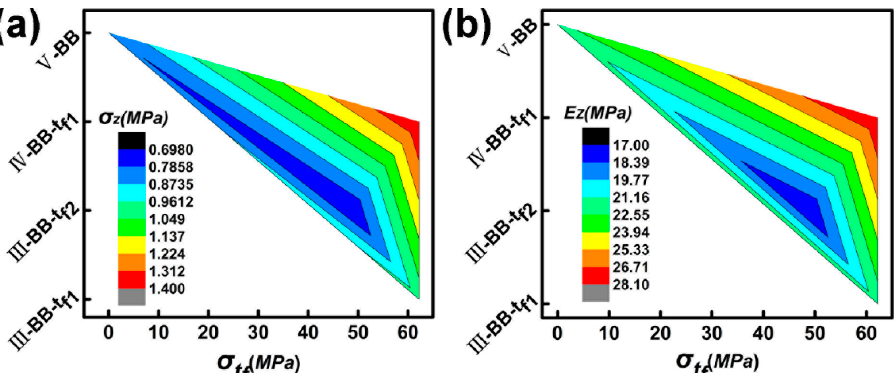
Figure 15. ( a ) Strength–strength of intermediate support plate–configuration comparison diagram. ( b ) Young’s modulus–the strength of intermediate support plate–configuration comparison diagram.